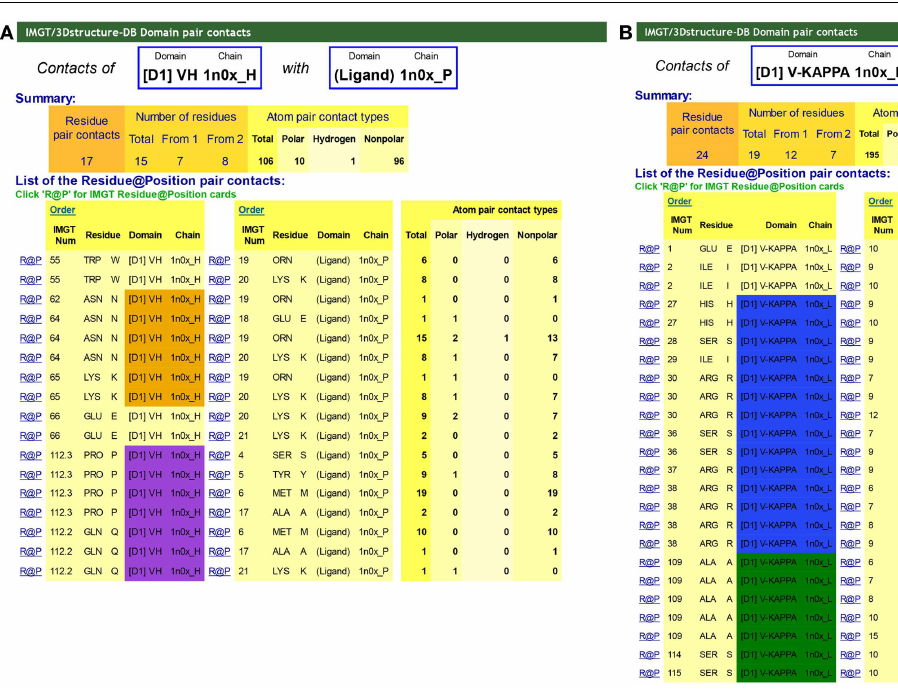
( Figure 3 ).The only two positions of the FR-IMGT that have contacts with the ligand are the anchors 55 and 66 of the CDR2-IMGT. In that structure, there is no contact of the CDR1-IMGT. (B) Domain pair contacts between V-KAPPA and the ligand.The Summary shows that there are a total of 195 atom pair contacts (32 polar including 3 hydrogen bonds and 163 non-polar) for 24 pair contacts between theV-KAPPA (1n0x_L) and the ligand (1n0x_P). Twelve AA of theVH interact with the ligand.The list of the pair contacts show that seven of them belong to the CDR1-IMGT (blue color online) and three of them to the CDR3-IMGT (greenblue color online) and together contribute to 174 atom pair contacts (including the three hydrogen bonds). The only two positions of the FR-IMGT that have contacts with the ligand are the positions 1 and 2 of the strand A of the FR1-IMGT. In that structure, there is no contact with the